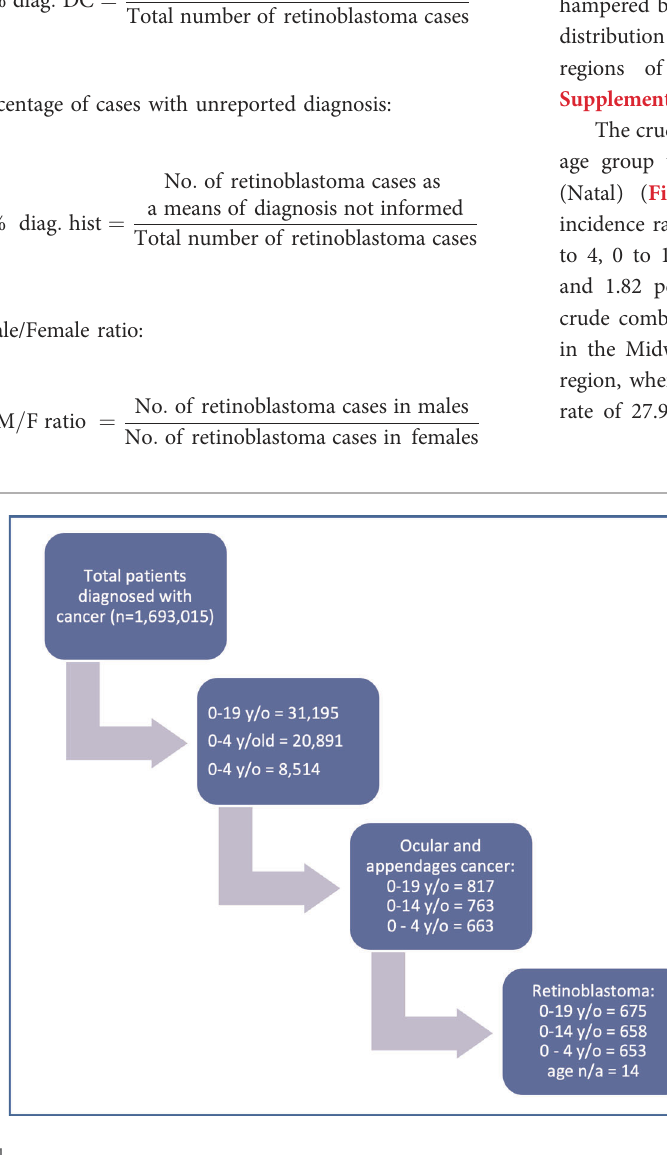
FIGURE 1 Selection of children and adolescents diagnosed with retinoblastoma, from 2000 to 2018, in Brazil, included in the Population-Based Cancer Registries of the National Cancer Institute, Ministry of Health,